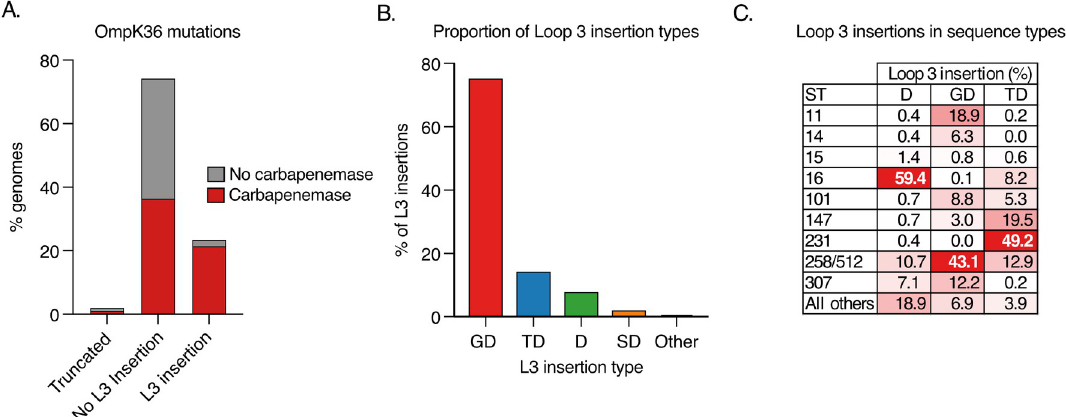
Fig 1. Diversity of loop 3 (L3) insertions among a collection of 16,086 public KP genomes. A . Proportion of genomes encoding an ompK36 gene that is truncated or possessing a L3 insertion (if intact). Bars are coloured by the proportion of genomes carrying one or more carbapenemase genes. Only genomes with a single copy of ompK36 that could be unambiguously characterised were included ( n = 15,193). B . Proportion of L3 insertions identified that comprise amino acid insertions of Glycine-Aspartate (GD), Threonine- Aspartate (TD), Aspartate (D), Serine-Aspartate (SD) or others (N/GG/TYD/YGS). C . Distribution of genomes possessing each L3 insertion type across major high-risk sequence types (ST). ST258 and ST512 are grouped together as they form a single clone.